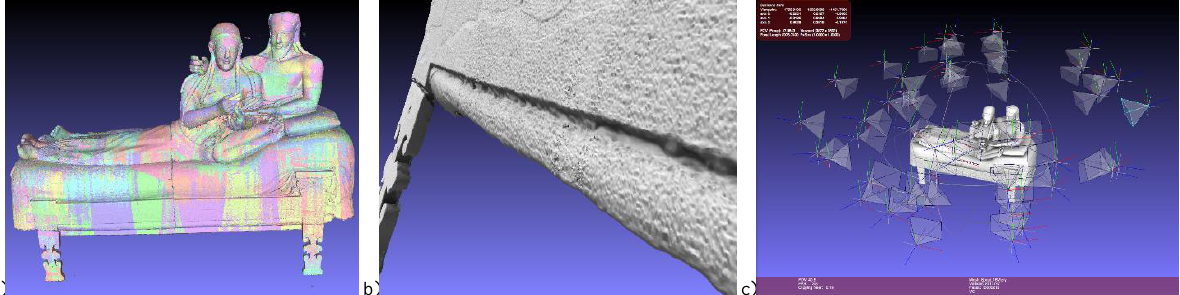
Figure 6. (a) Visualization of the aligned range maps. It can be noted that a minor redundancy and overlapping is present in the lower part of the Sarcophagus. (b) Artefacts generated by small misalignments of range maps. (c) Estimated camera positions for some of the images used for colour